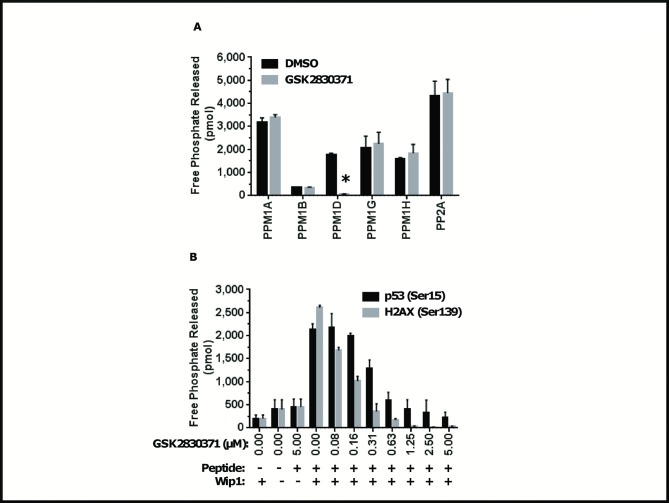
GSK2830371 selectively inhibits WIP1 among related phosphatases.
A, Release of free phosphate was measured after incubation of each recombinant enzyme with the generic phosphopeptide, RRA(pT)VA. (* p < 0.01). B, GSK2830371 inhibits the dephosphorylation of WIP1 substrates. Release of free phosphate was measured after exposure of PPM1D (WIP1) to increasing concentrations of GSK2830371, followed by a reaction with phosphopeptide substrates, H2AX (Ser-139) and p53 (Ser-15). Error bars represent SD.